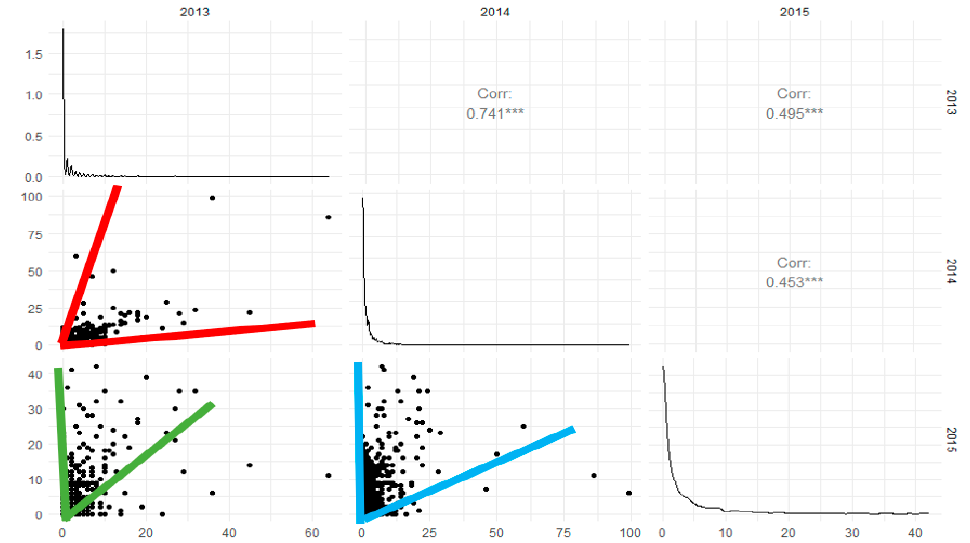
Figure 3. Scatterplot matrix of the total number of insects through the years.